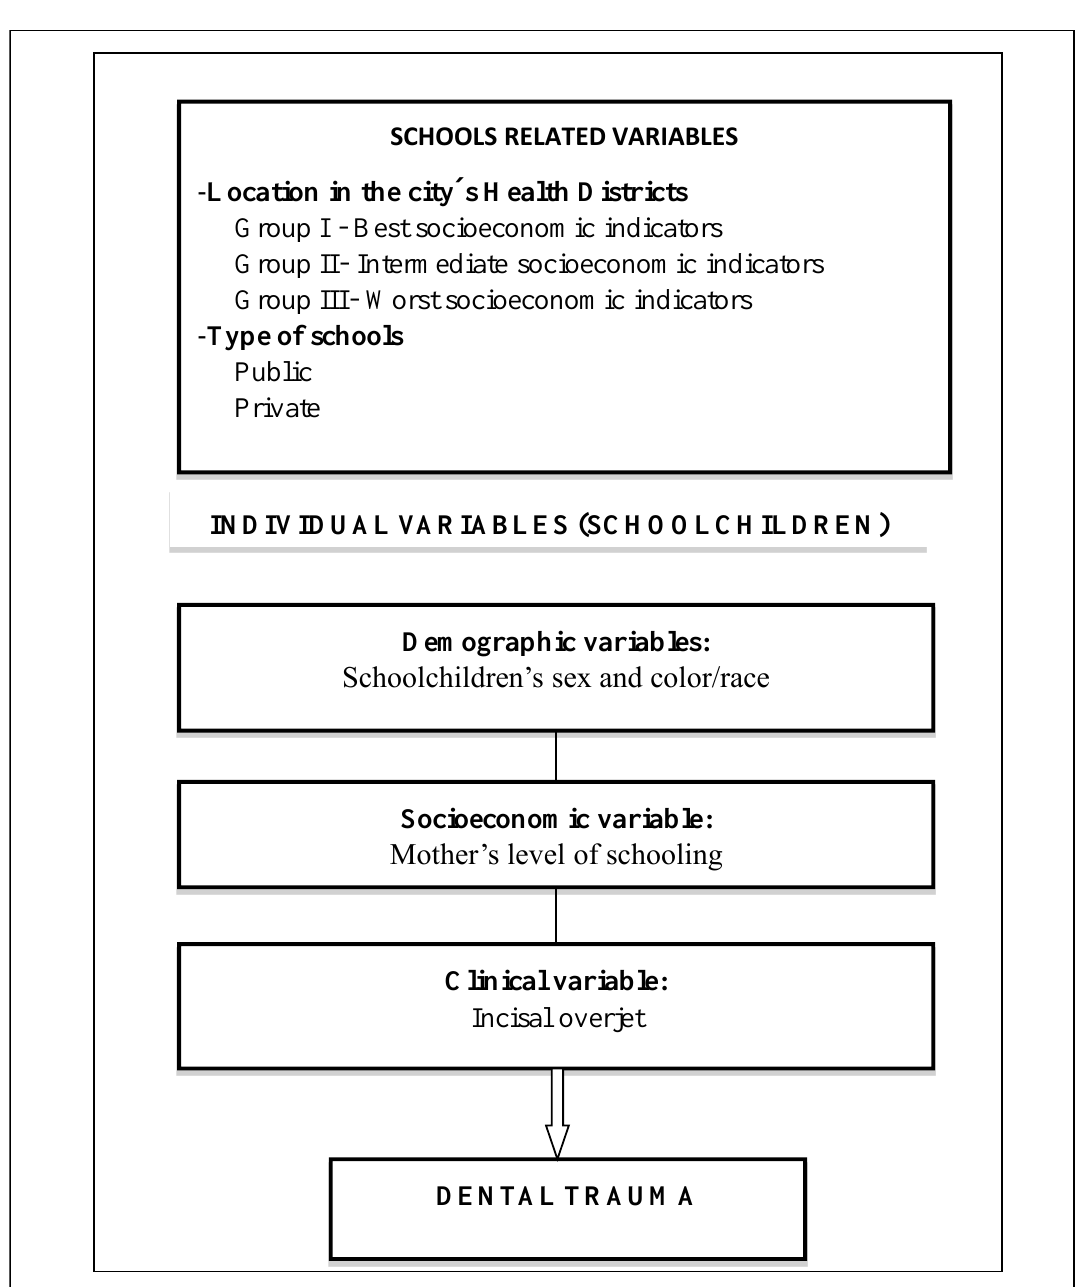
Figure 1. Theoretical hierarchical proposed model of the association between individual and schools related factors and dental trauma of 12-year-old